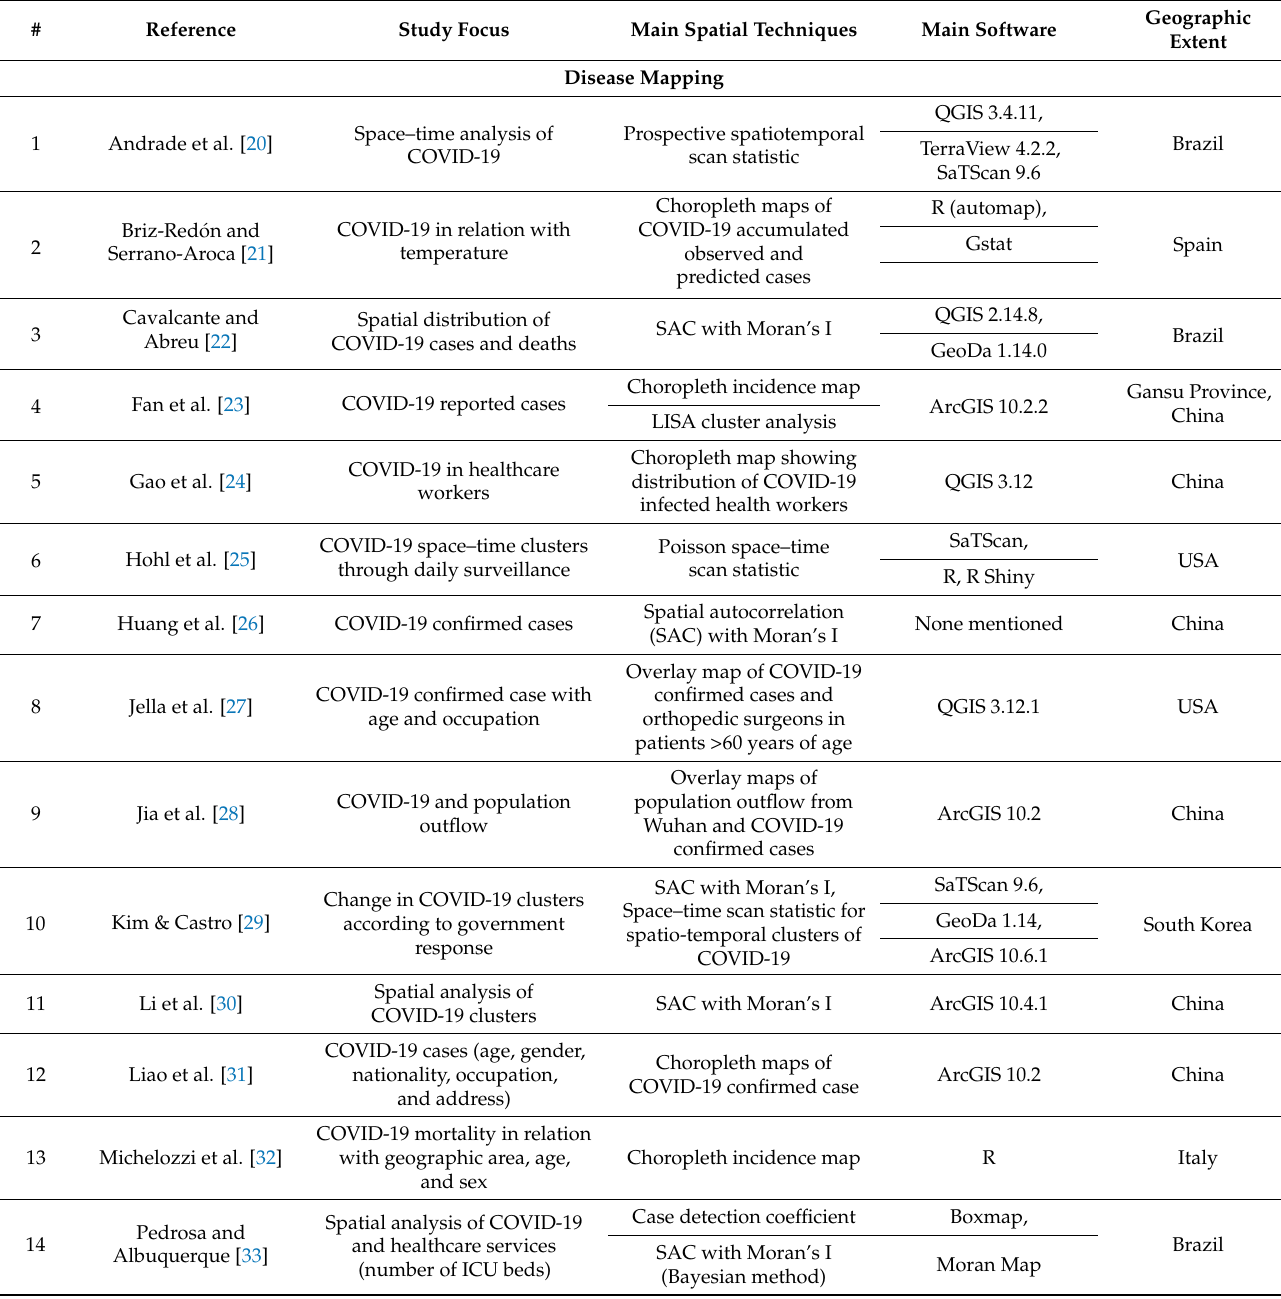
Table 1. Second-stage screening records and their study focus, main spatial techniques, software, and geographic ex- tent, grouped by approach: disease mapping, exposure mapping, and spatial epidemiological modeling. SAC = spatial autocorrelation